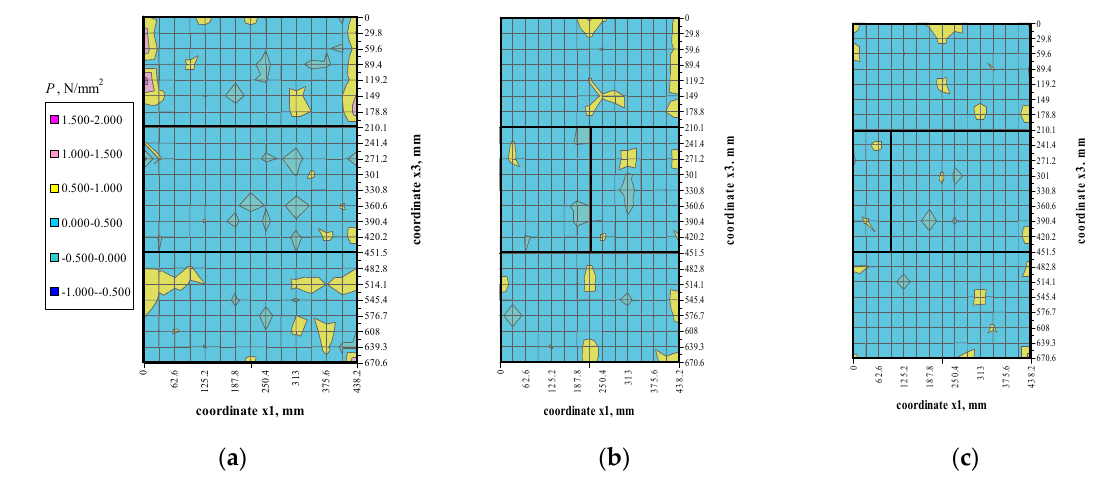
Figure 14. Mean hydrostatic stress values P at load σ 3 = 0.25 σ 3max : ( a ) model I-1, ( b ) model II-1, ( c ) model III-1.